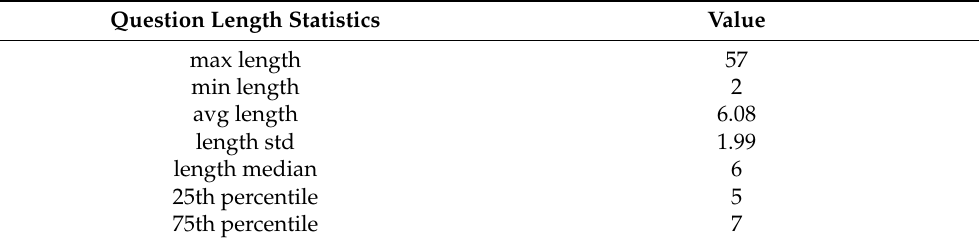
Figure 3. Histogram of document lengths. The X-axis represents the question (document) length, which is the number of words in each question. The Y-axis represents the number of questions with the specific value of question length. Most of the questions have a length between 4 and 8 words. Table 6. Statistics of question length. The question length refers to the number of words in each question. The maximum question length is 57 words, and the minimum question length is 2 words. The average length of questions is 6.08 words.